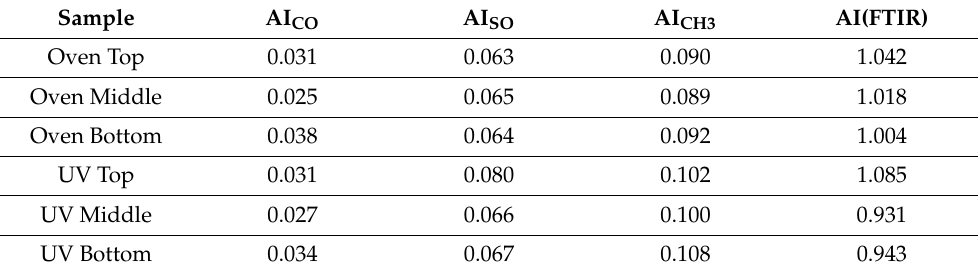
Table 8. Aging Index from FTIR